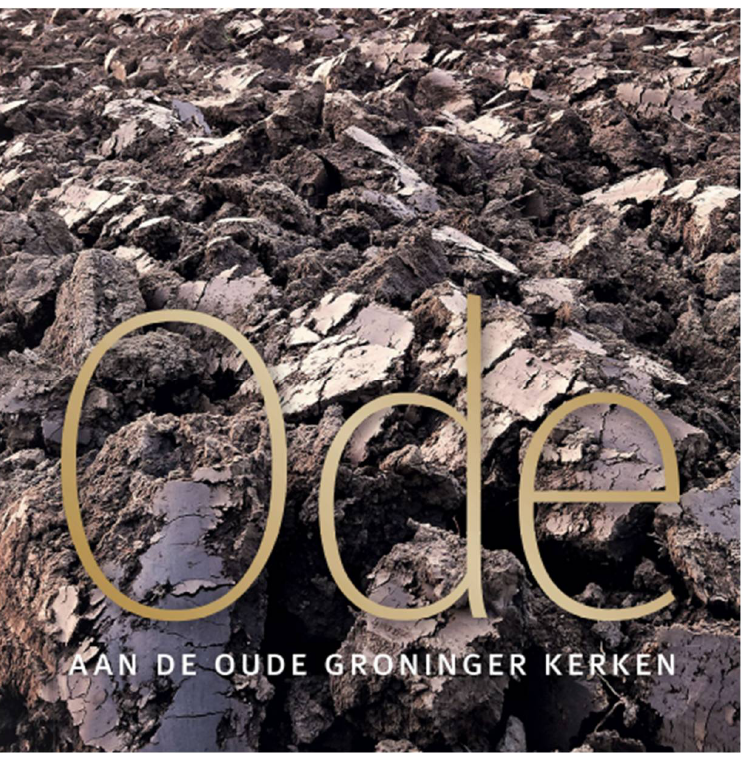
Figure 2. Marjoleine de Vos and Justin Kroesen, Ode aan de Groninger kerken , 2019, book cover.